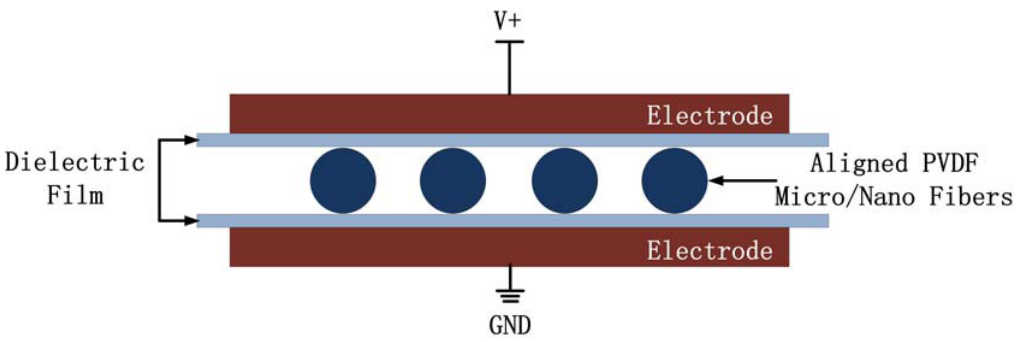
Figure 11. Scheme diagram of an innovated poling device for PVDF micro/nano fiber